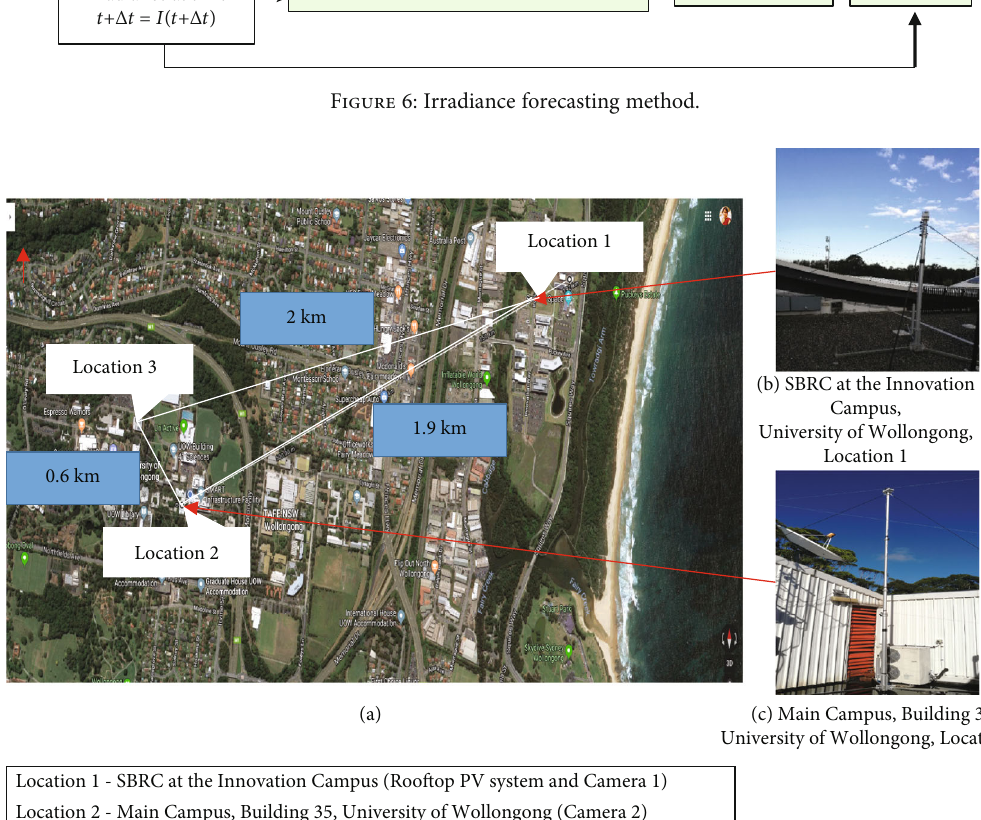
Figure 7: (a) Locations of two cameras and locations of rooftop PV plants, (b) camera 1 at location 1, and (c) camera 2 at location